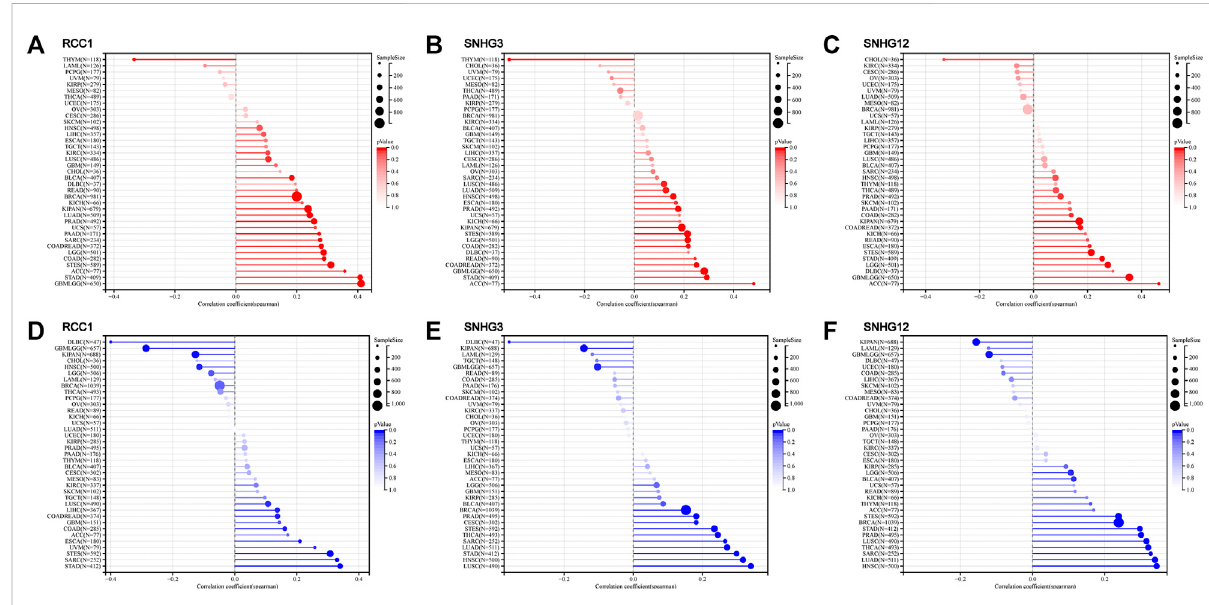
Correlation between RCC1, SNHG3, SNHG12 expression and TMB/MSI in cancers. (A – C) TMB. (D – F)